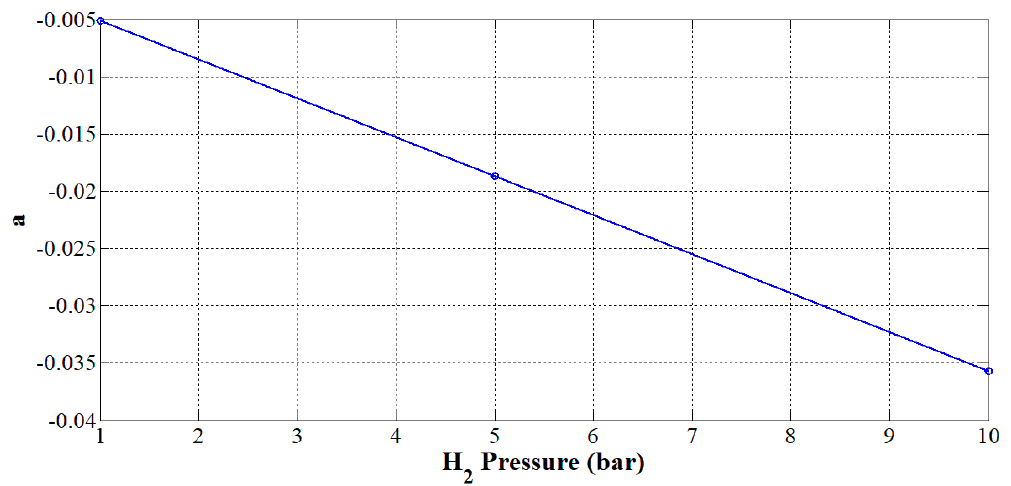
Figure 6. E ff ect of the hydrogen pressure on parameter a Figure 6. Effect of the hydrogen pressure on parameter a .